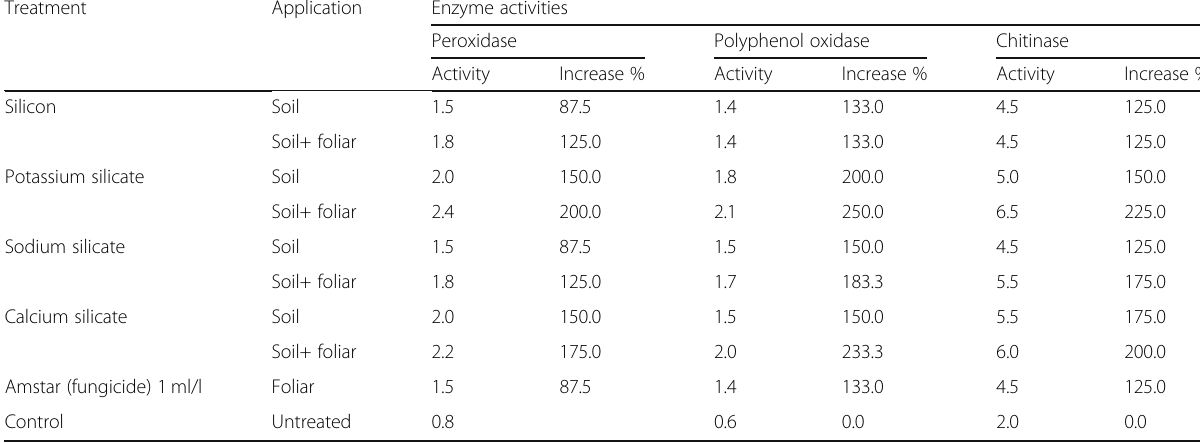
Table 4 Effect of silicon and potassium, sodium and calcium silicates, and a fungicide on enzyme activities of strawberry plants under field